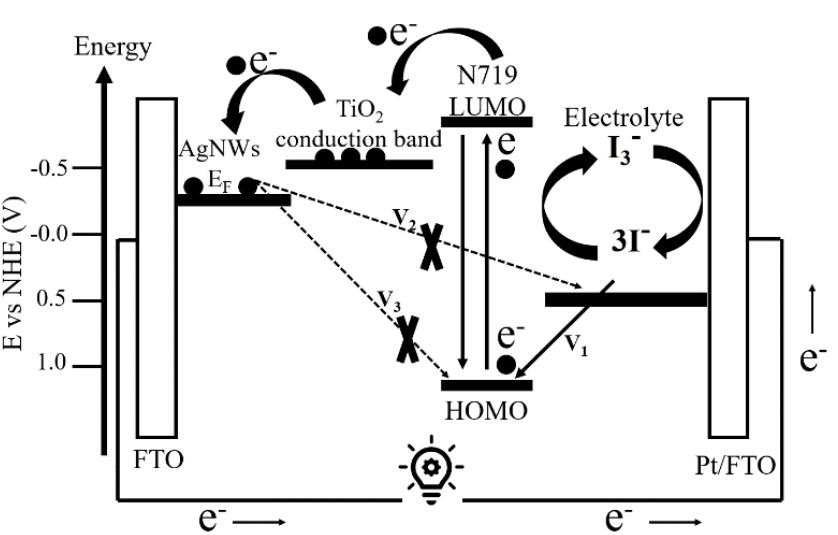
Figure 8. Schematic illustration of the interfacial charge transfer recombination process that occurs with the AgNWs@TiO 2 based DSSCs. V 1 represents the redox reaction between the oxidation N719 molecules and the iodine electrolyte. V 2 represents the recombination reaction between injected electrons and redox electrolytes. V 3 represents the recombination reaction between injected electrons and oxidized N719 molecules.